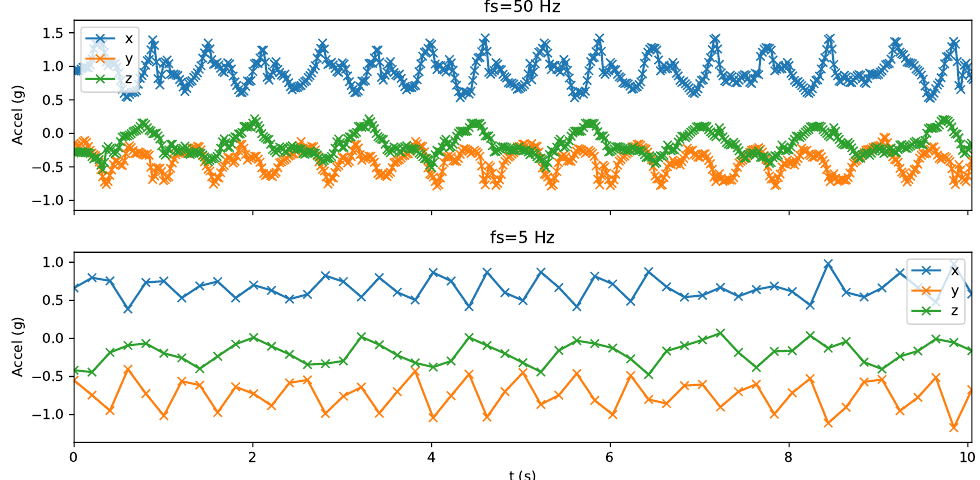
Figure 3. The raw data ( top ) at 50 Hz, and resampled 5 Hz ( bottom ). Notice that the high-frequency aspects of the accelerometer data are removed with lower sampling frequencies. Samples are marked with symbols. The x , y and z axes are depicted in blue, orange and green ×